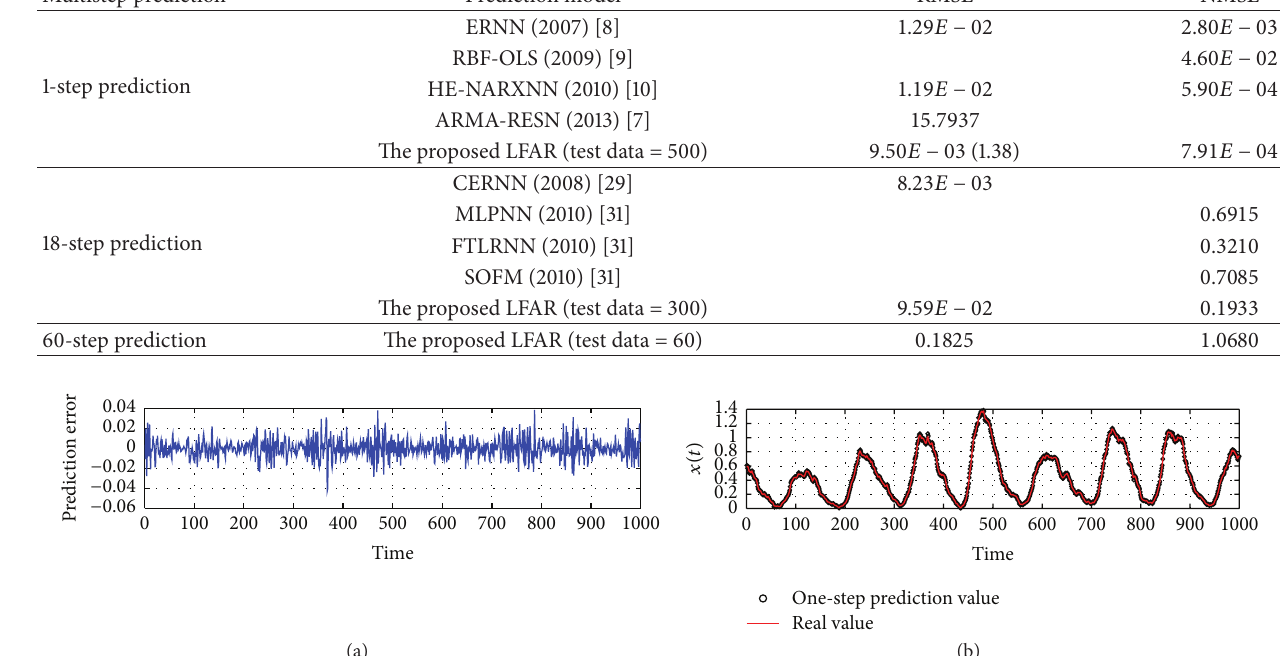
Table 3: The comparative results of different models of Sunspot time series ( (𝑟 Multistep prediction